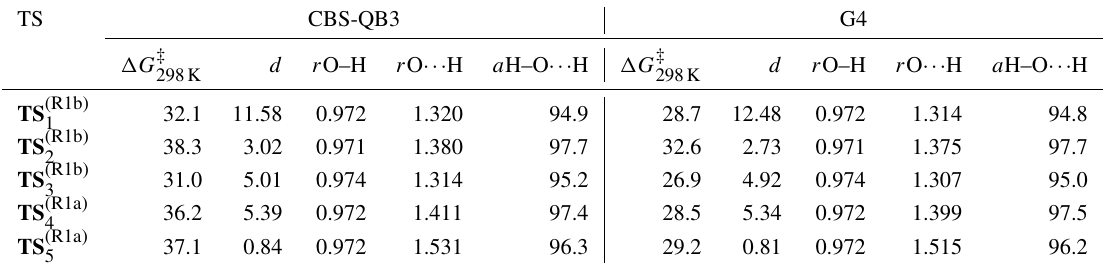
) a , MWDs ( d ) b between TS and pre-reaction complexes, and key structural param- 298K and TS (R1a) at the CBS-QB3 and G4 levels of 1 − 3 4 − 5